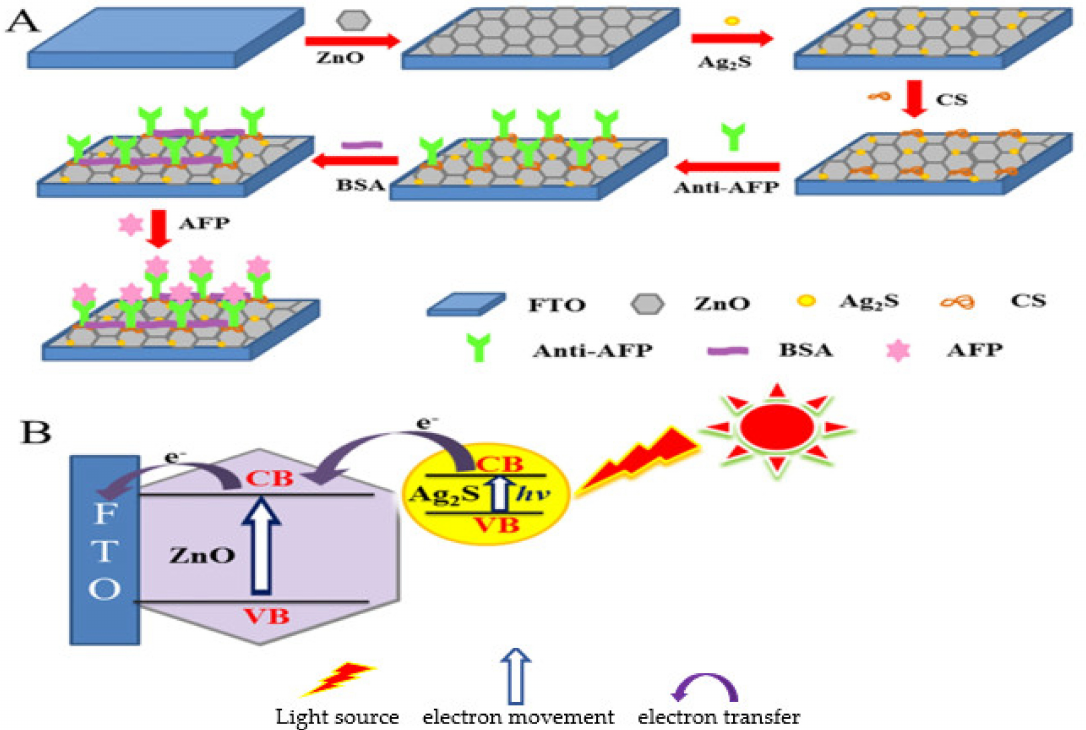
Figure 25. Schematic development process of the immunosensor ( A ) and photocurrent activity of ZnO/Ag2S nanocomposites ( B ). VB: valence band; CB: conduction band; e: electron